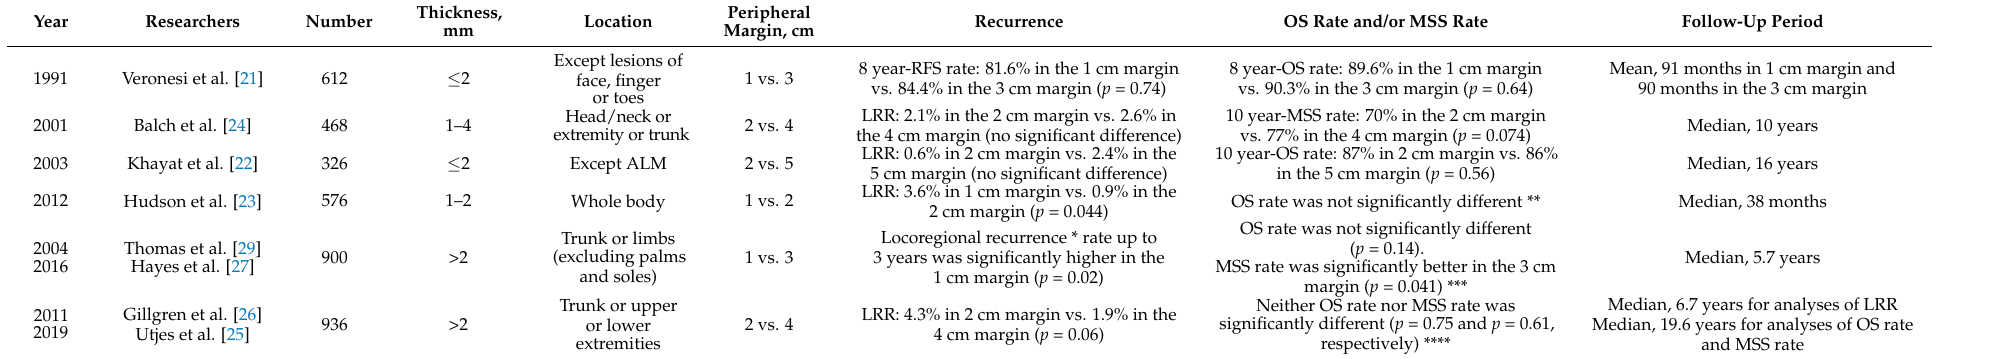
Table 1. Previous randomized controlled trials to evaluate peripheral surgical margins for melanoma.